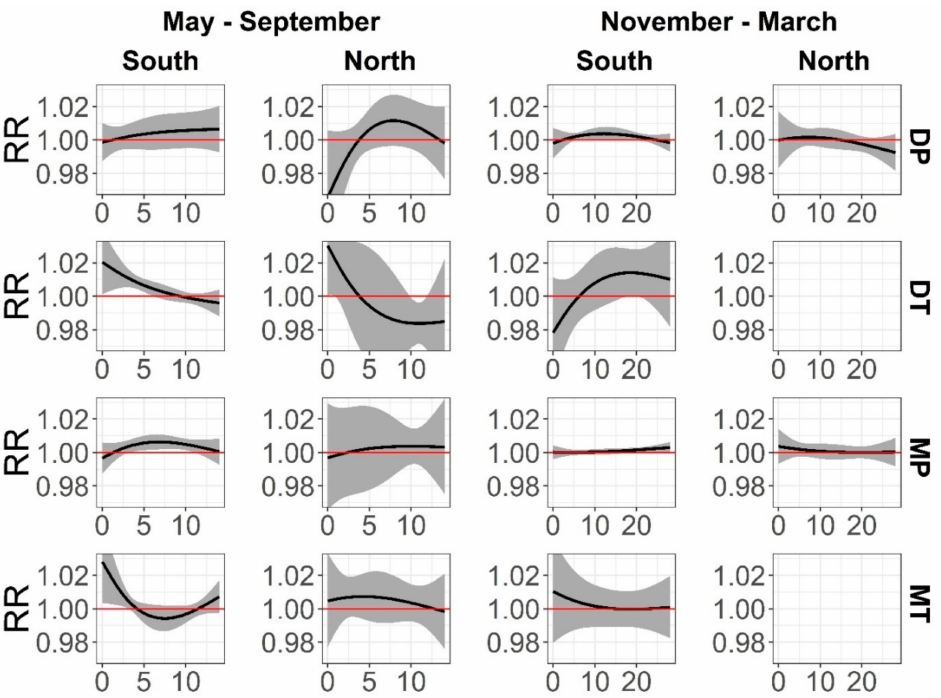
Figure 2. RR (with 95% CI) of all-cause mortality by oppressive weather type at di ff erent lags from 1991 to 2014 for summer (May–September) and winter (November–March), respectively. RR and 95% CI for DT and MT weather types could not be estimated for northern locations because of their rare occurrence during the